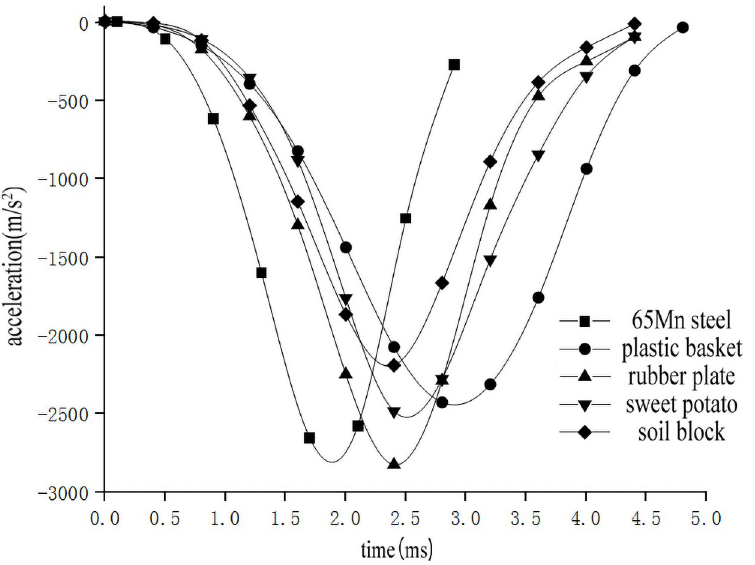
Fig 13. Acceleration-time relationship when impacting with different collision